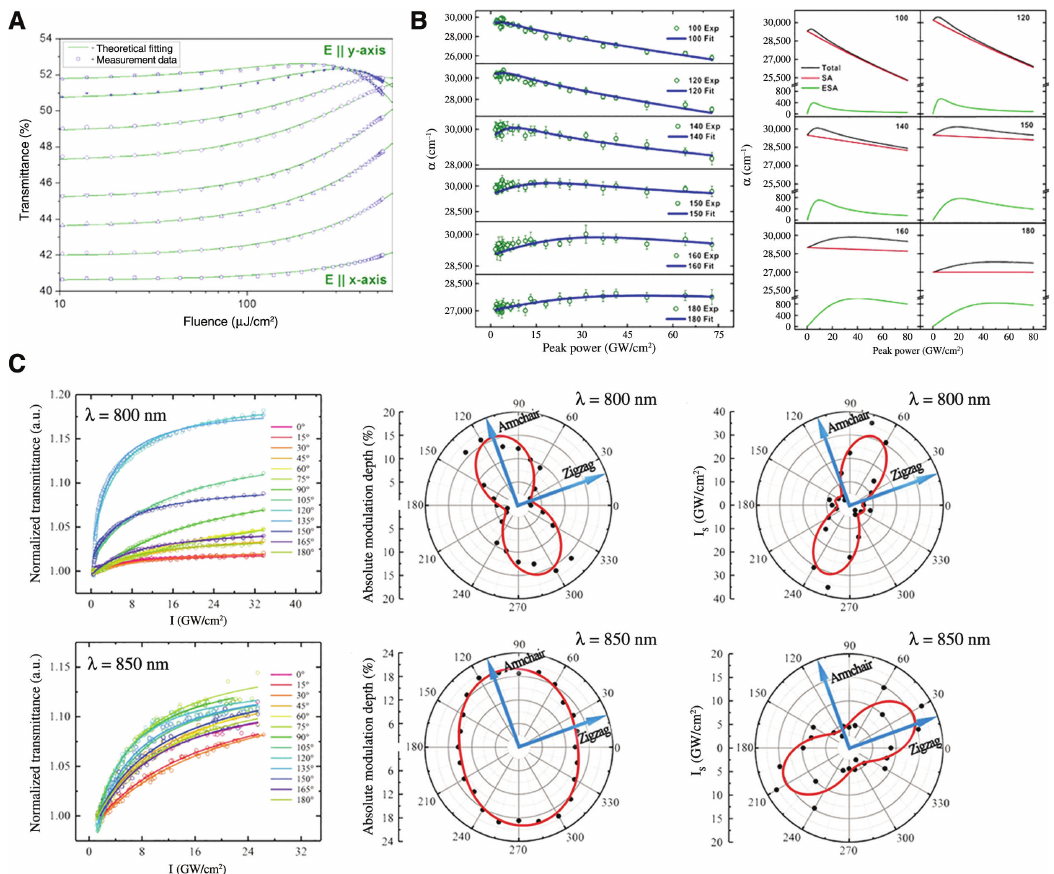
Figure 4: The measured power-dependent transmittance against different polarization. (A) The exfoliated BP. Reproduced with permission from Sotor et al. [107]. (B) ReS : the angle-resolved absorption coefficient against power 2 and the involved mechanisms including the saturation absorption and excited saturation absorption. Reproduced with permission from Meng et al. [94]. (C) SnSe: the normalized transmission against intensity at 800 and 850 nm; the corresponding polar plots of the absolute modulation depth as well as saturation intensity in terms of polarization. Reproduced with permission from Zhang et al.